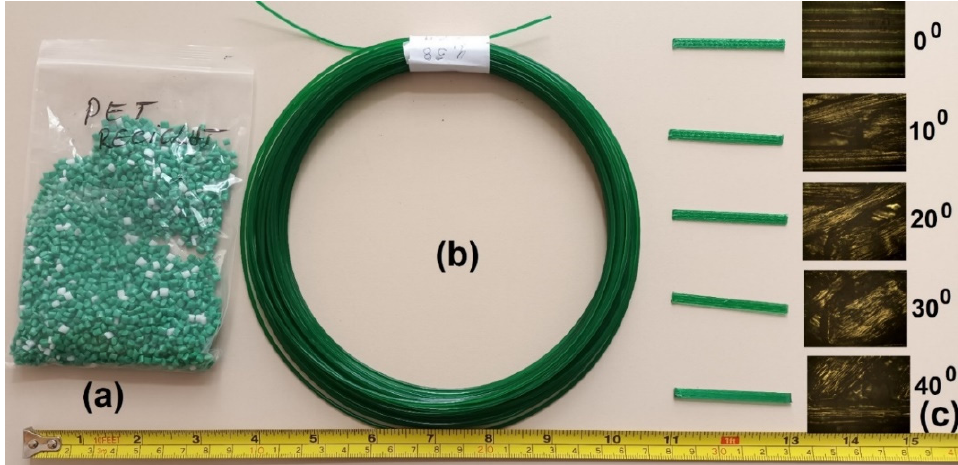
Figure 2. Images of raw materials and specimens: ( a ) R-PET grains; ( b ) 3D filament; ( c ) 3D printed specimens with corresponding OM details of the five different angles between their longitudinal axes and filament deposition direction.